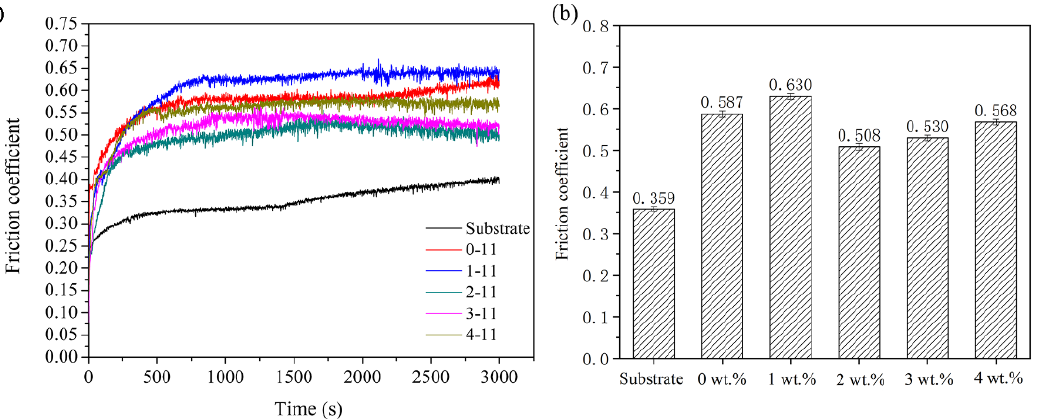
Figure 10. The friction coefficient of composite coatings with various CeO 2 contents. ( a ) friction coefficient curve; ( b ) the average coefficient of friction. coefficient curve; ( b ) the average coefficient of